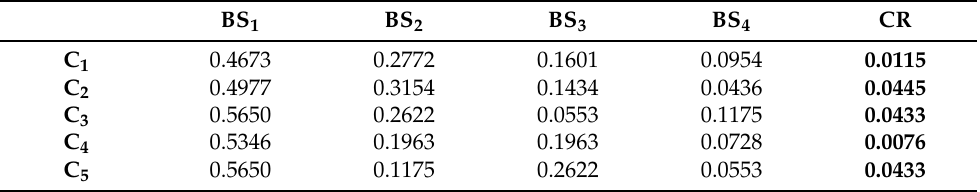
Table A6. The normalized eigenvector and CR of five pairwise comparison matrices. The CR of each matrix is in